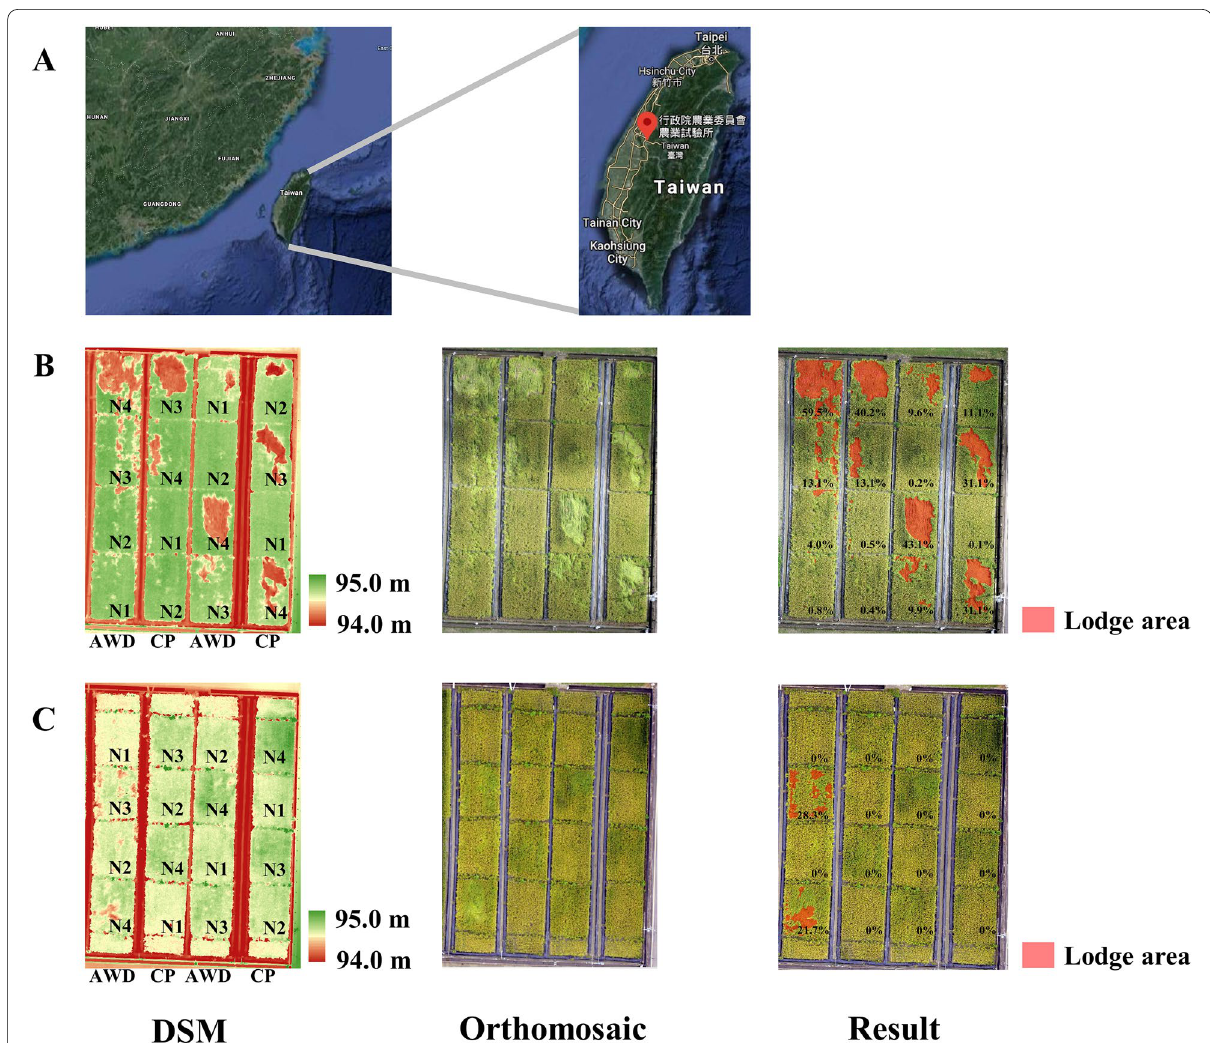
Fig. 1 Geographical location of the experiment field and aerial lodging image of TNG 71. A Rice field trials were conducted in the central region of Taiwan in 2019 and 2020. B Aerial lodging image for 2019. C Aerial lodging image for 2020. The digital surface model (DSM) diagram indicates the height difference of the field area; the green block represents the higher area, and the red block represents the lower area. The orthomosaic image is spliced from aerial images. The resulting image is a combination of the DSM image and orthomosaic image; the red block represents the lodging area, and the value represents the lodge area rate. N Fertilizer treatment level is divided into 80 (N1), 120 (N2), 160 (N3), and 200 (N4) kg/ha. AWD alternative wet and dry cultivation. CP conventional plant